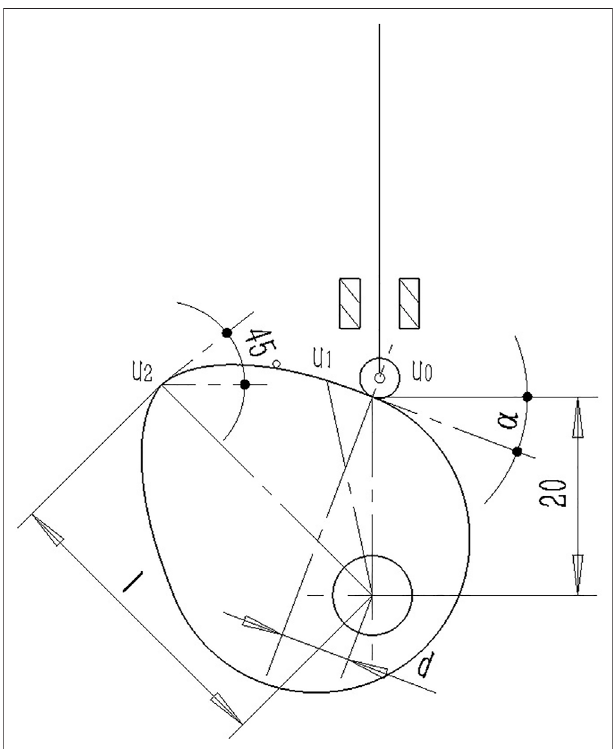
FIGURE 4 | Structure diagram of the knee cam and roller follower.